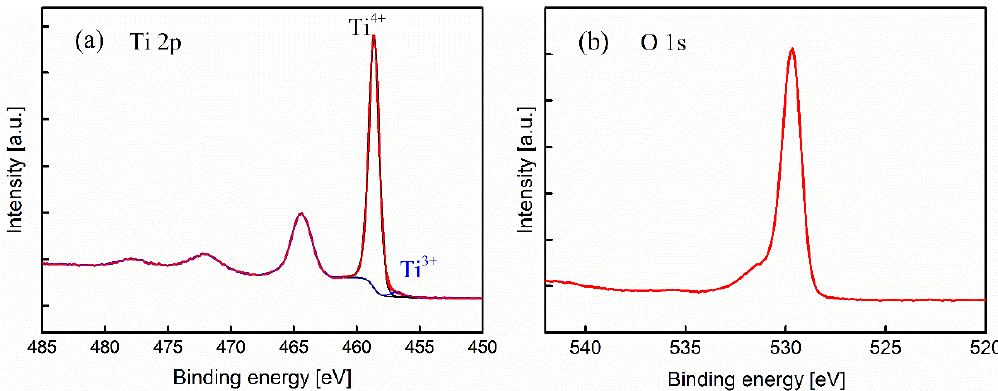
Figure 9. High resolution spectra of TiO 2 nanoparticles showing ( a ) Ti 2p peak and ( b ) O 1s peak for pure TiO 2 .